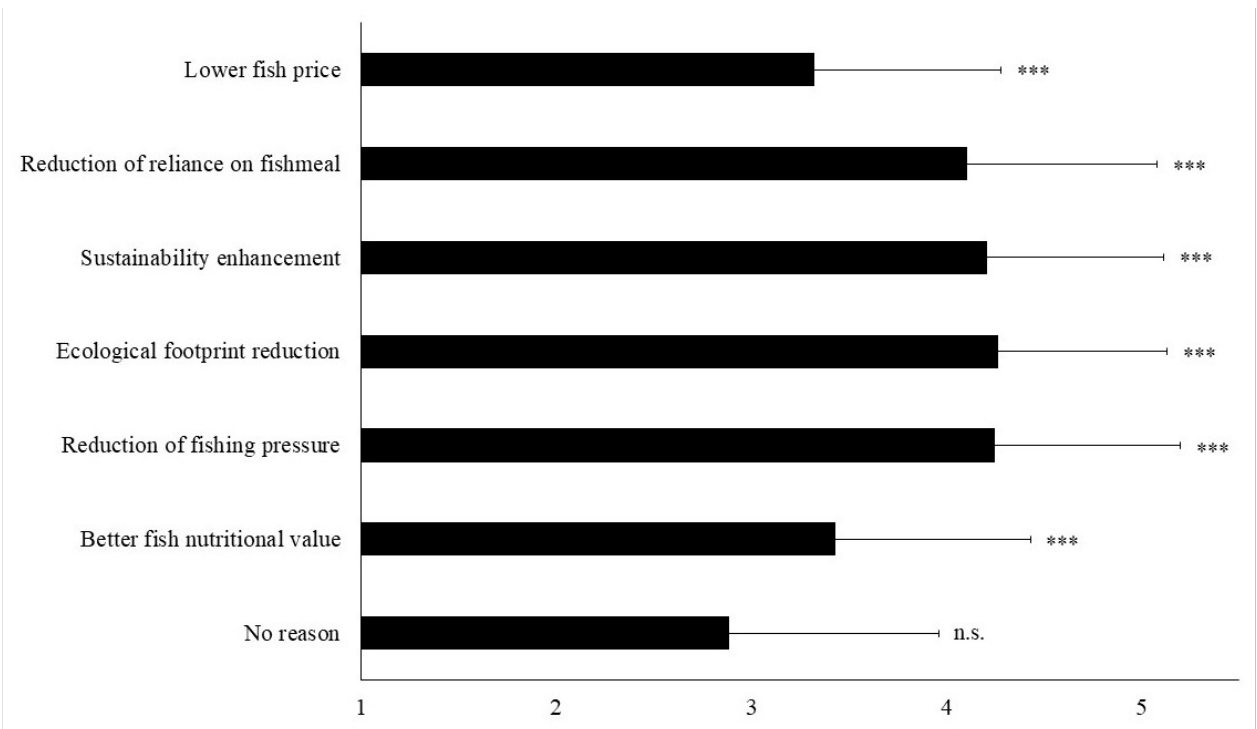
Figure 2. Mean attribute perception scores ( ± Standard Deviation) among participants willing to consume fish fed with insects for the main reasons that dictate their attitude. Answers were given on a five-point Likert scale with response categories ‘1 = strongly disagree’, ‘2 = disagree’, ‘3 = neutral’, ‘4 = agree’, ‘5 = strongly agree’ (n = 162). Asterisks denote statistical differences (*** p < 0.001) after an one-sample t-test with test value = 3; n.s.—not significant.